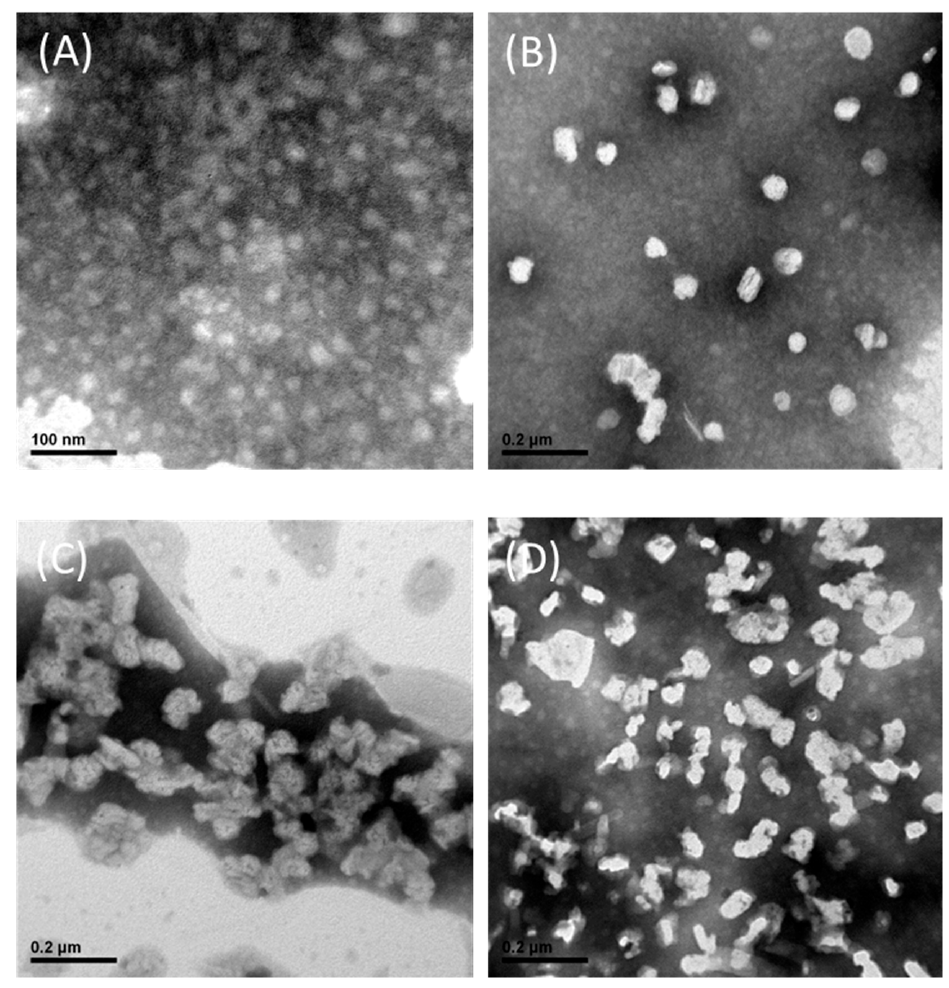
Figure 1. TEM images of mPEG-PCL micelles ( A ), SN-38 micelles ( B ), Sunitinib micelles ( C ) and SN-38/Sunitinib micelles ( D ). Abbreviations: mPEG-PCL, methoxy poly-(ethylene glycol)-poly ( ε -caprolactone).